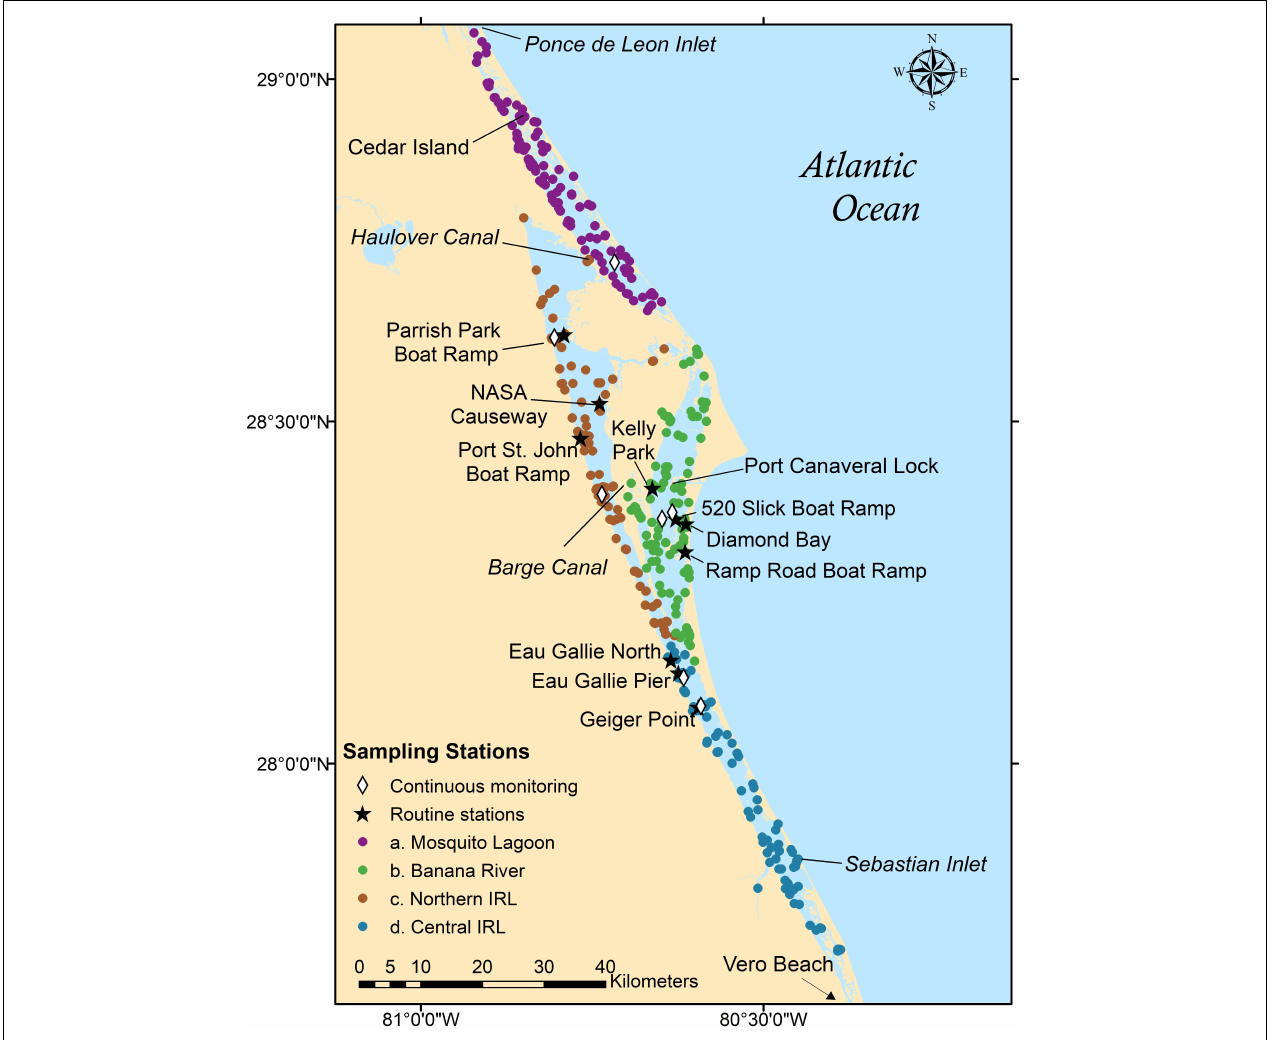
FIGURE 1 | Map of the Indian River Lagoon (IRL) system showing the four sub-basins monitored: Mosquito Lagoon (purple), Banana River Lagoon (green), Northern IRL (brown), and Central IRL (blue). Filled circles represent all sampling locations over the 2015–2020 time period, and black stars represent the ten routine fixed stations that were sampled on a regular basis over the course of this time period (Parrish Park Boat Ramp, NASA Causeway, Port St. John Boat Ramp, Kelly Park, 520 Slick Boat Ramp, Diamond Bay, Ramp Road Boat Ramp, Eau Gallie North, Eau Gallie Pier, and Geiger Point). White diamonds represent the St. Johns River Water Management District continuous monitoring stations used in this